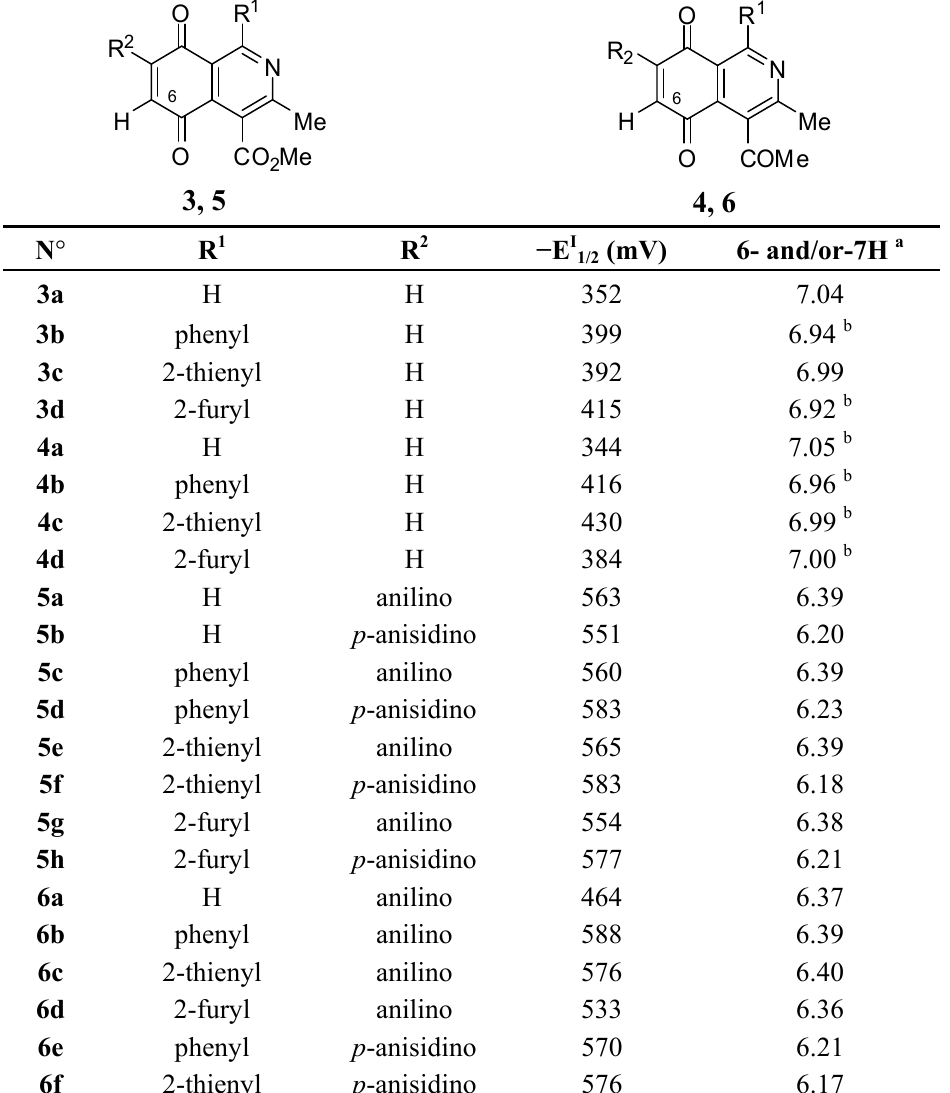
and proton quinone-chemical shifts of the new compounds. 1/2